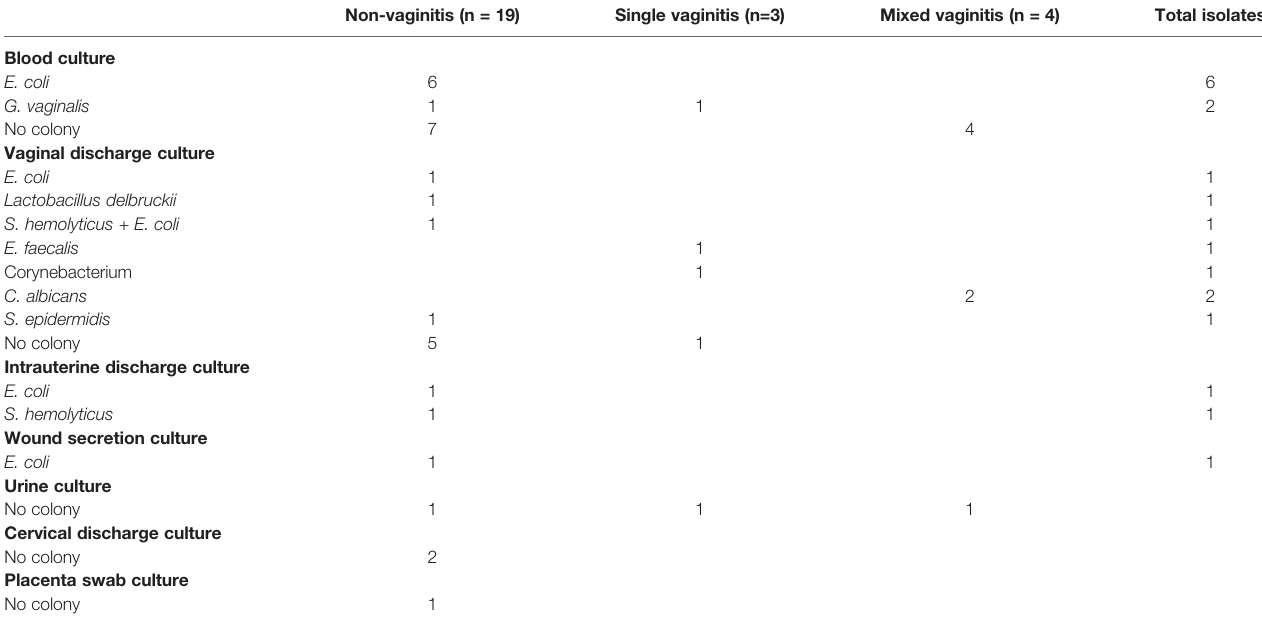
TABLE 6 | Pathogenic isolation characteristics of patients with peripartum